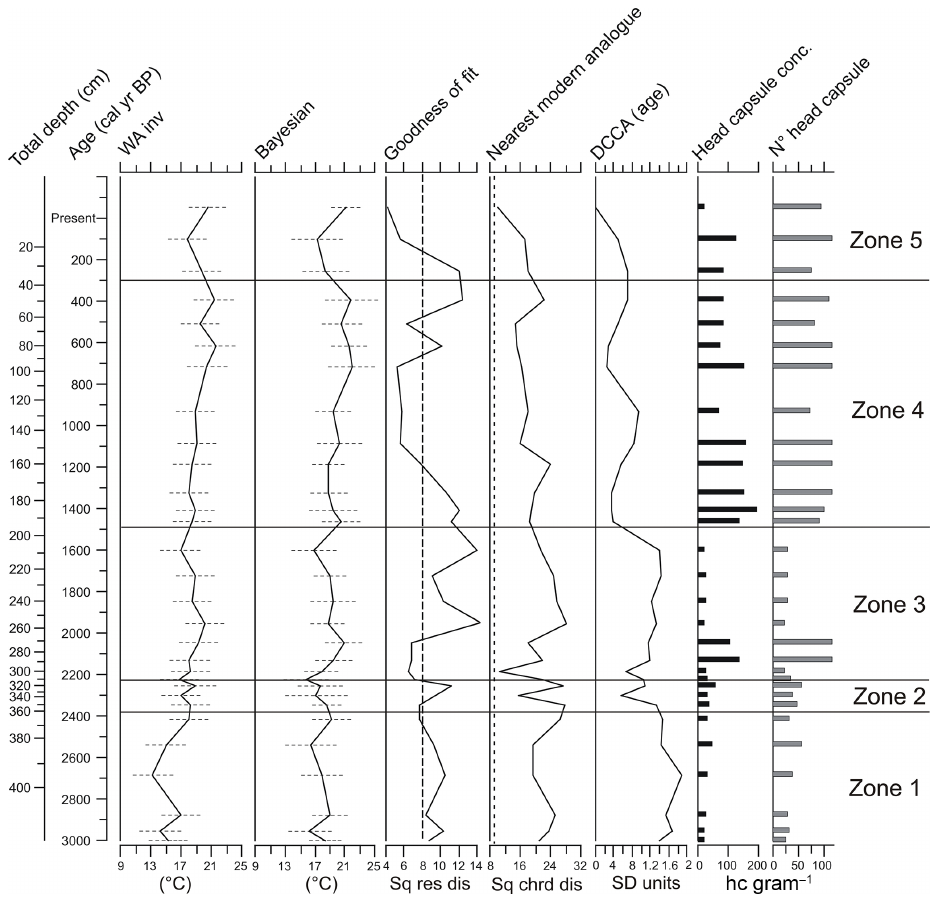
Figure 10. Left to right: chironomid-inferred WA inverse MAT with sample-specific errors generated using bootstrapping. Bayesian re- construction with sample-specific errors. Goodness of fit of the fossil assemblages to temperature: vertical dotted line indicates the 90th percentile of squared residual distances of modern samples to first axis in a CCA; samples to the right of the line have a poor fit to tempera- ture. Nearest modern analogue analysis: vertical dotted line indicates the 5th percentile of squared chord distances of the fossil samples in the modern calibration data set; samples to the right of the line have no good modern analogues. Detrended canonical correspondence analysis (DCCA) sample scores, with radiocarbon age used as the sole constraining variable. Head capsule concentration per gram of sediment. Zones are derived from optimal partitioning of fossil assemblages using a broken-stick model to define significant zones. Sq res dis: square residual distance; Sq chrd dis: square chord distance; SD units: standard deviation units; hcgram − 1 : head capsule per gram of